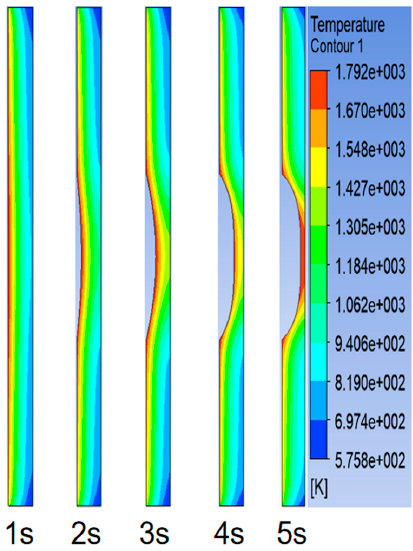
Figure 11. The heating process of the steel target.